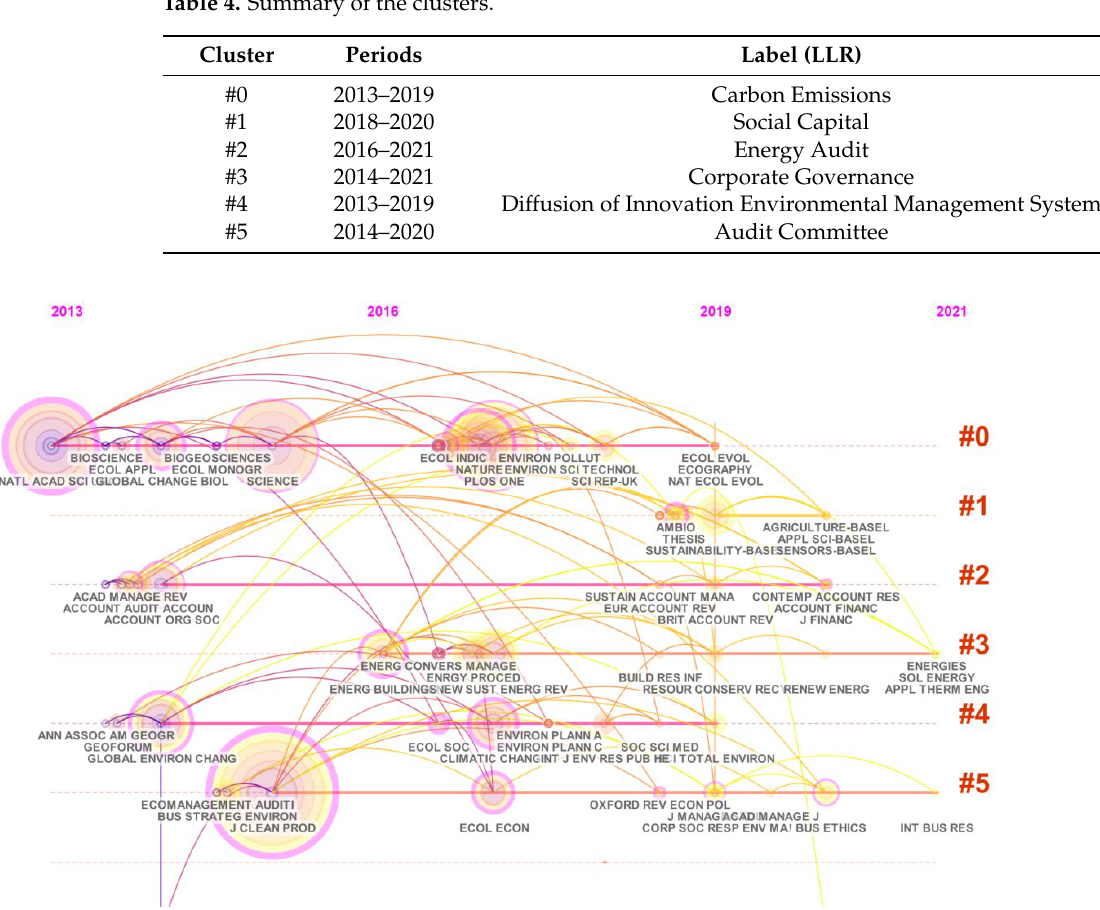
Table 4. Summary of the clusters.